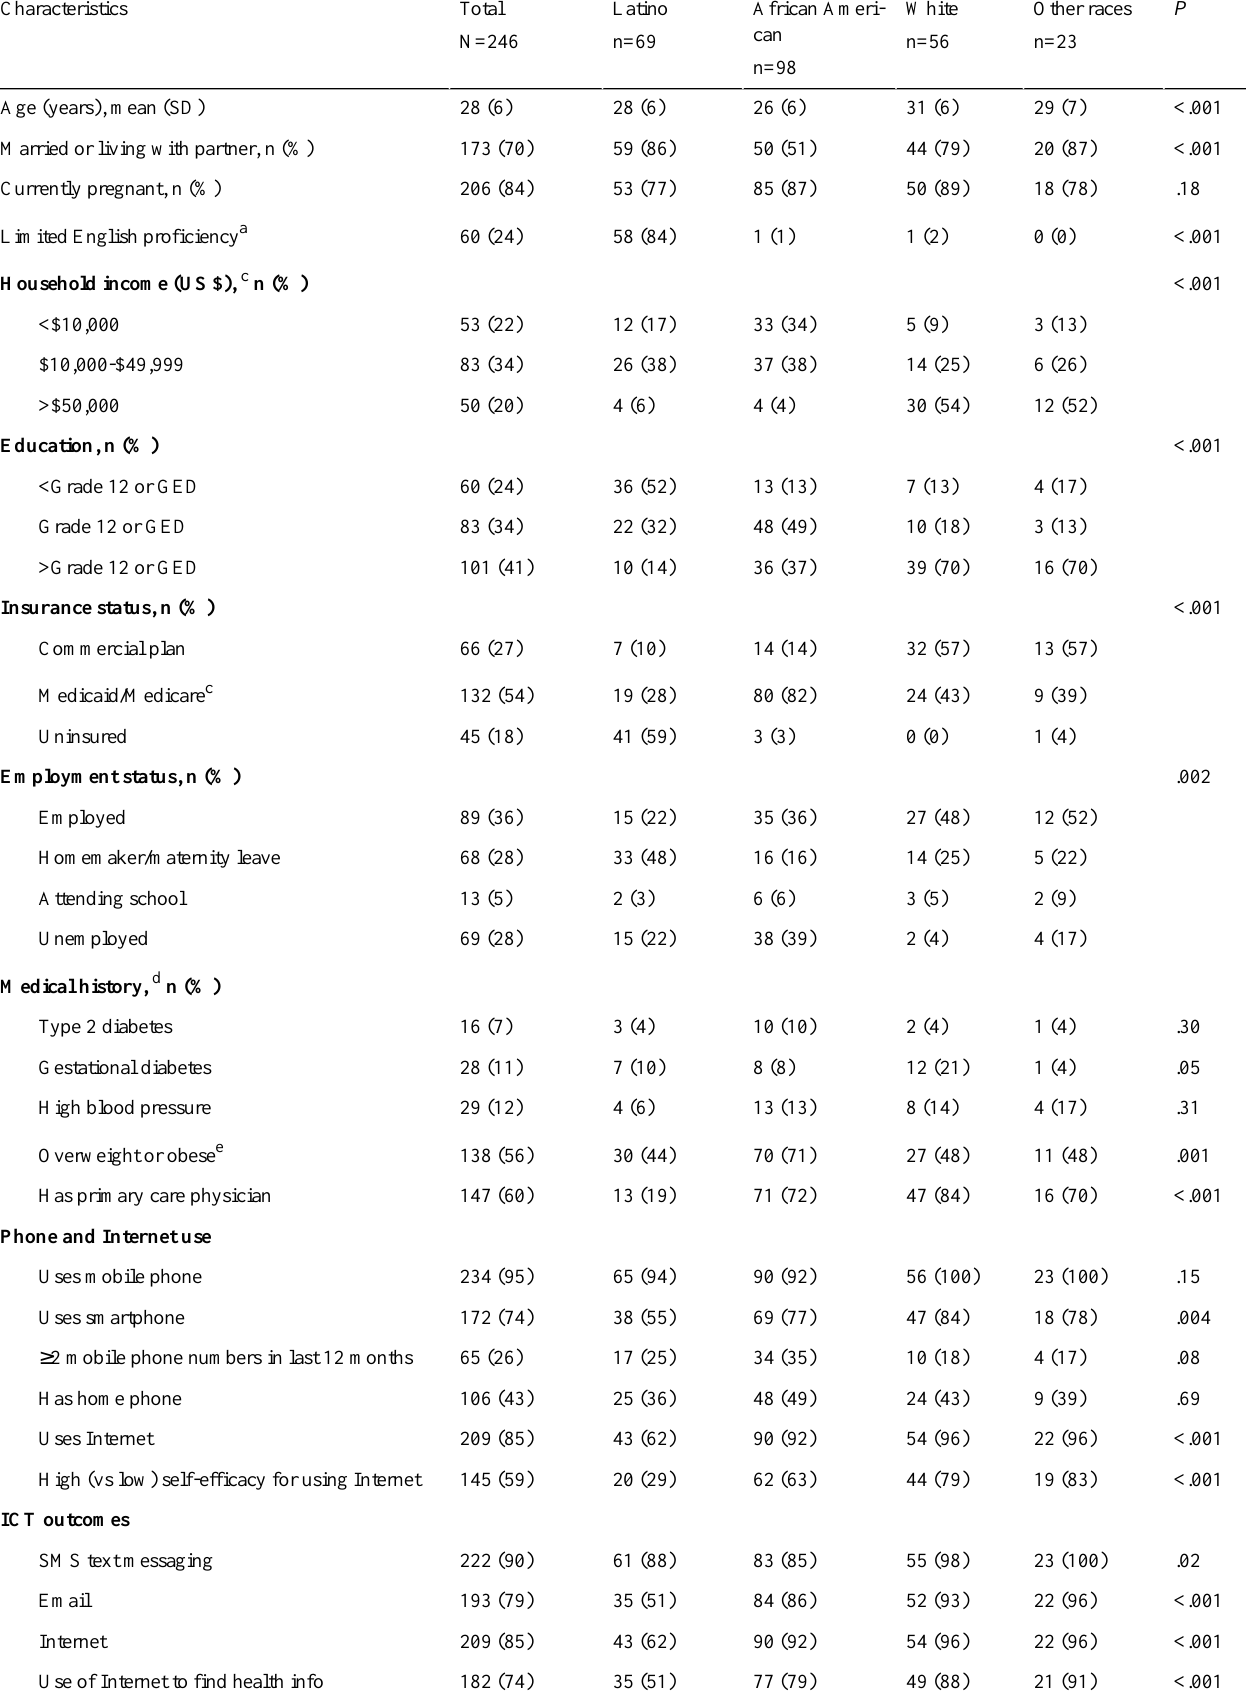
P Other races n=23White n=56African Ameri-